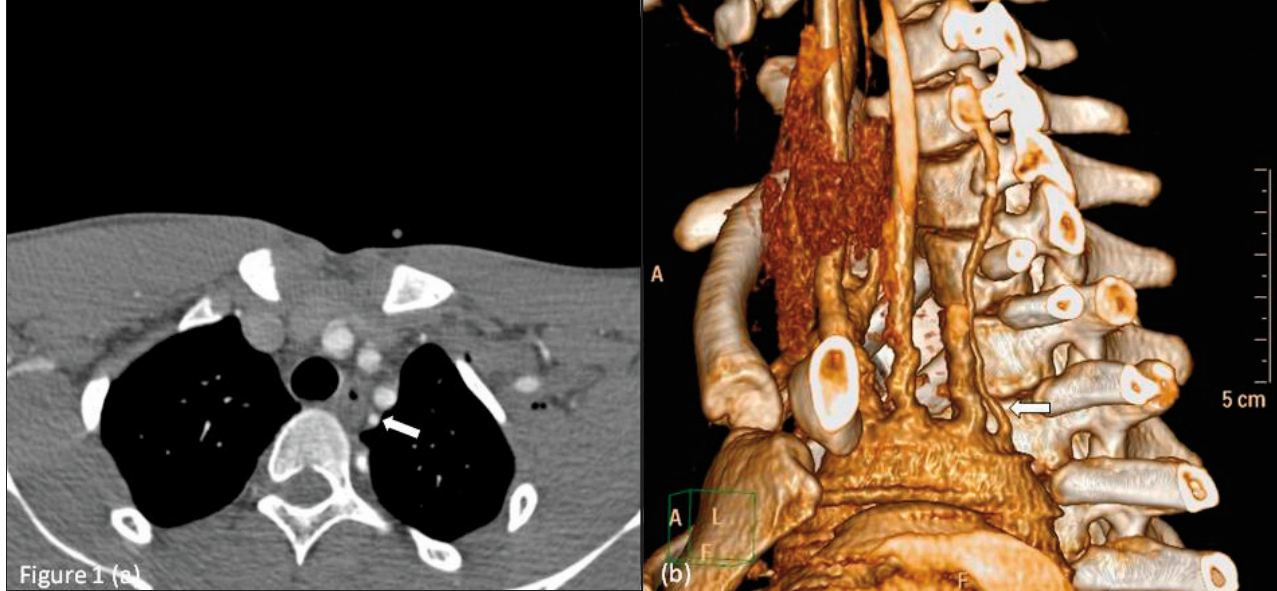
Fig. 1. (a) CT angiogram (b) and 3D reconstruction. The left vertebral artery (white arrows) with anomalous origin from the aortic arch distal to the left subclavian artery was demonstrated in one